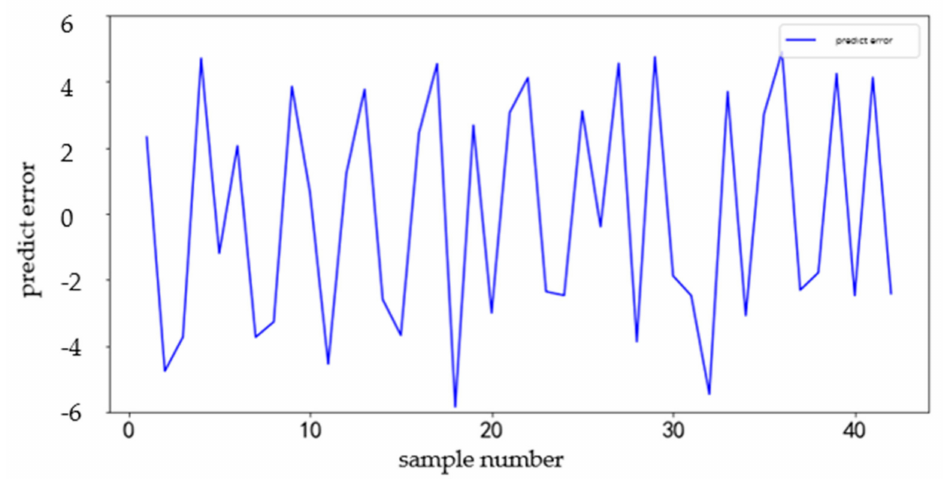
Figure 15. Error graph on station collection